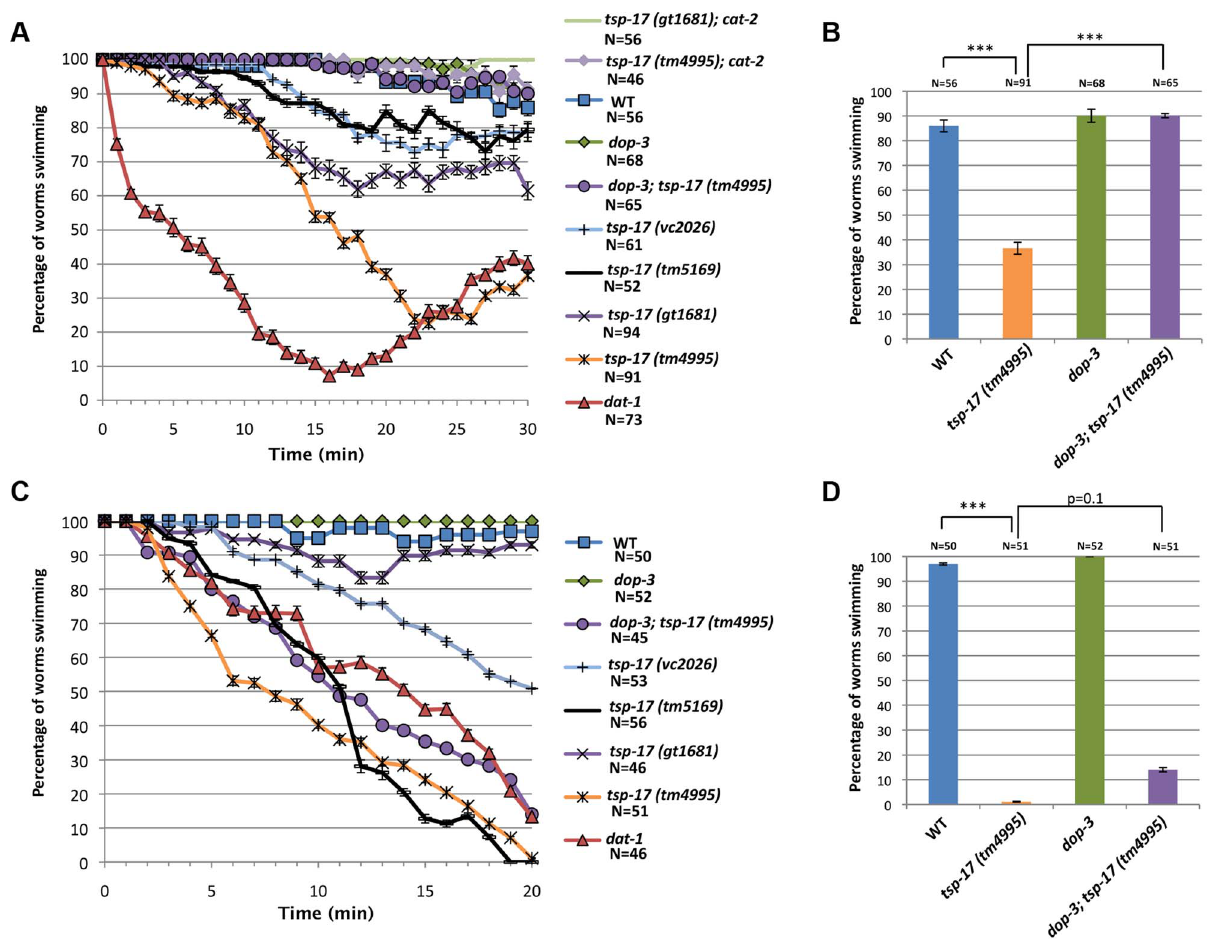
Figure 5. Behavioral phenotypes associated with tsp-17 mutants. A . Quantitative analysis of SWIP behavior at L4-stage, over 30 minutes. B . The SWIP phenotype of tsp-17(tm4995) in L4-stage worms is rescued by dop-3 deletion. C . Quantitative analysis of SWIP behavior in L1-stage worms over 20 min. D . The SWIP phenotype of tsp-17(tm4995) at L1 stage is not rescued by dop-3 deletion. Assays were done in triplicate for the total number of worms indicated by N values. Error bars represent the standard error of the mean. Asterisks represent statistically significant differences from the wild-type (***p , 0.01). To facilitate comparison, strains are indicated by the same color code.